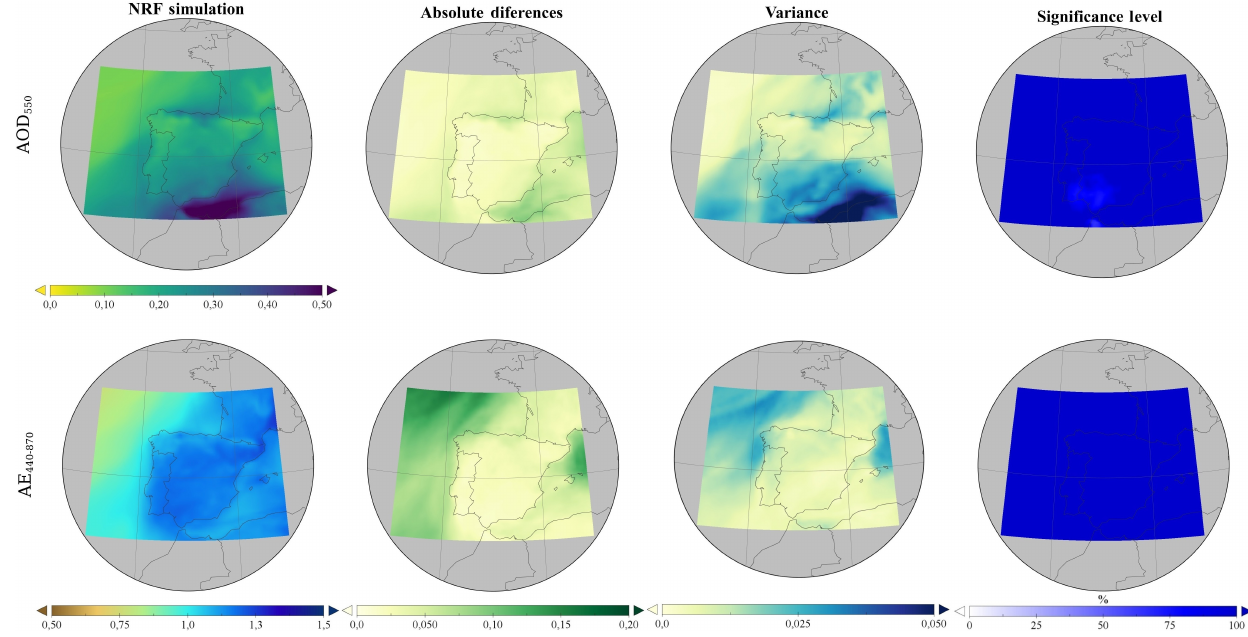
Figure 2. Dust episode (temporal mean from 28 June to 12 July). Top: AOD 550 , bottom: AE 440 / 870 . From left to right: modelled value of the variable (NRF simulation), value of the absolute differences between NRF-RF simulations (absolute differences), variance value of NRF simulation (variance) and significance level (S.L.)